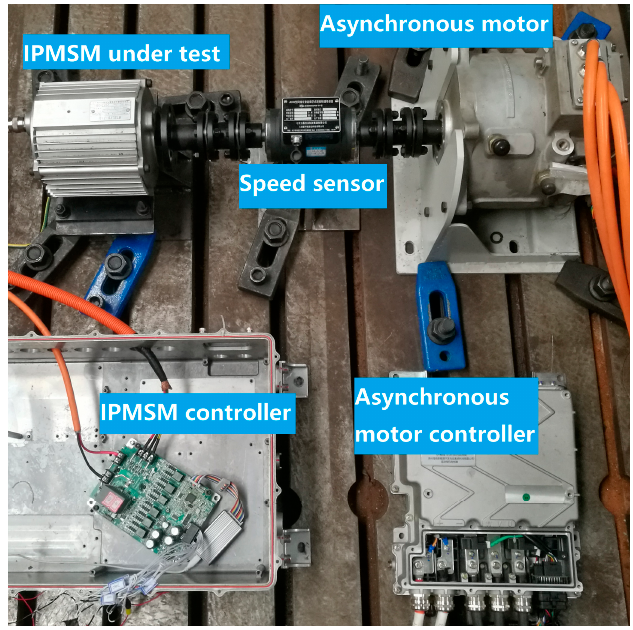
Figure 5. Experimental setup.